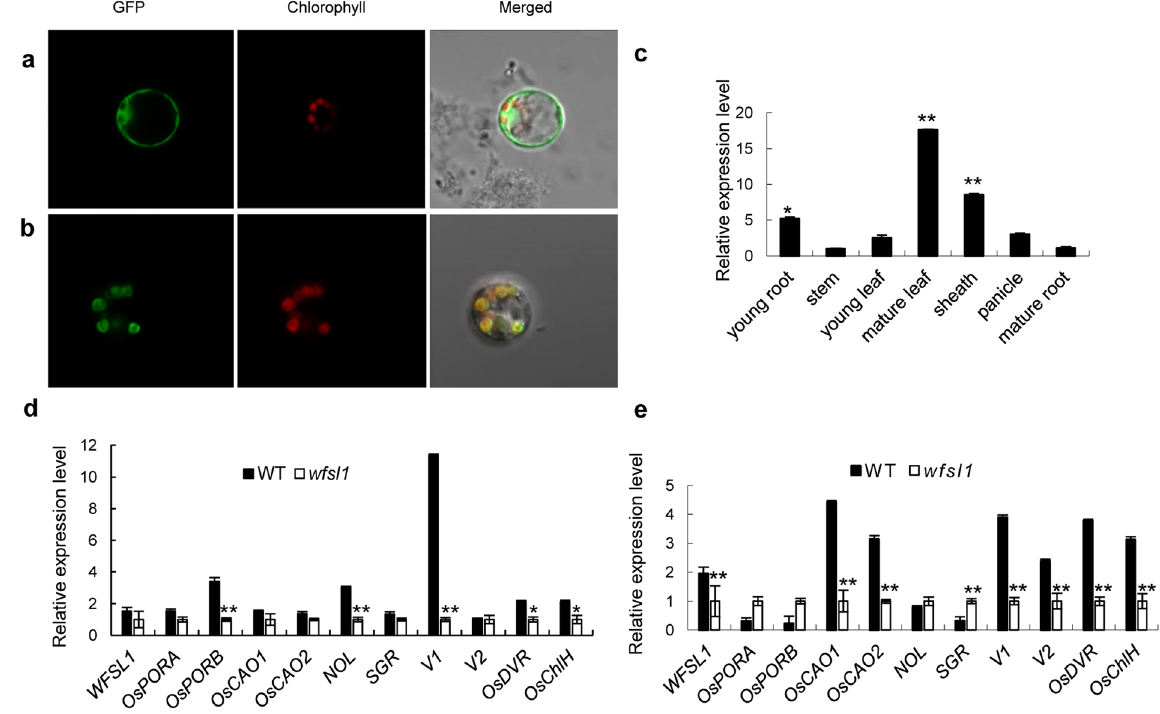
Figure 5. Subcellular localization and expression pattern analysis of WFSL1 . ( a , b ) Localization of GFP (control) and WFSL1 protein in rice protoplasts. Green fluorescence shows GFP, red fluorescence shows chlorophyll, orange indicates the two types of florescence merged. ( c ) qRT-PCR analysis WFSL1 expression in young root, stem, young leaf, mature leaf, sheath, panicle and mature root of wild type. The relative expression level of stem represents “1”. ( d , e ) Relative expression levels of some genes of chloroplast synthesis, degradation and development. Error bars represent the SD from three independent experiments. (Student’s t -test, * P < 0.05; ** P <